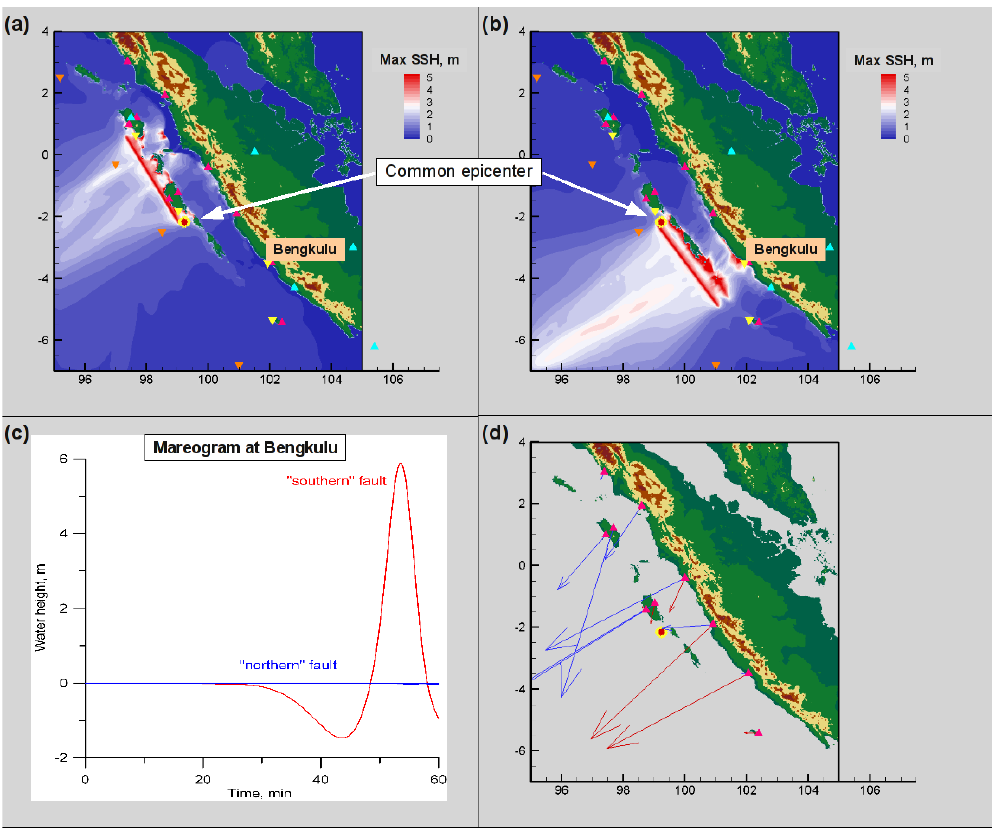
Fig. 1. Two hypothetical scenarios offshore Sumatra demonstrating extreme sensitivity of local tsunamis to rupture position (which is not fully defined by the seismic epicenter!) and local bathymetry as well as high prediction potential of near real-time GPS observations. (a) Maximum tsunami wave heights in case of unilateral rupture propagating northwards from the epicenter (red-yellow dot). (b) Rupture propagates in the opposite direction. (c) Resulting mareograms at Bengkulu. (d) Array of GPS stations can perfectly discriminate between the two scenarios in few minutes on an event.